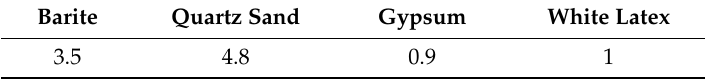
Table 5. Mass proportion of the adhesive used.